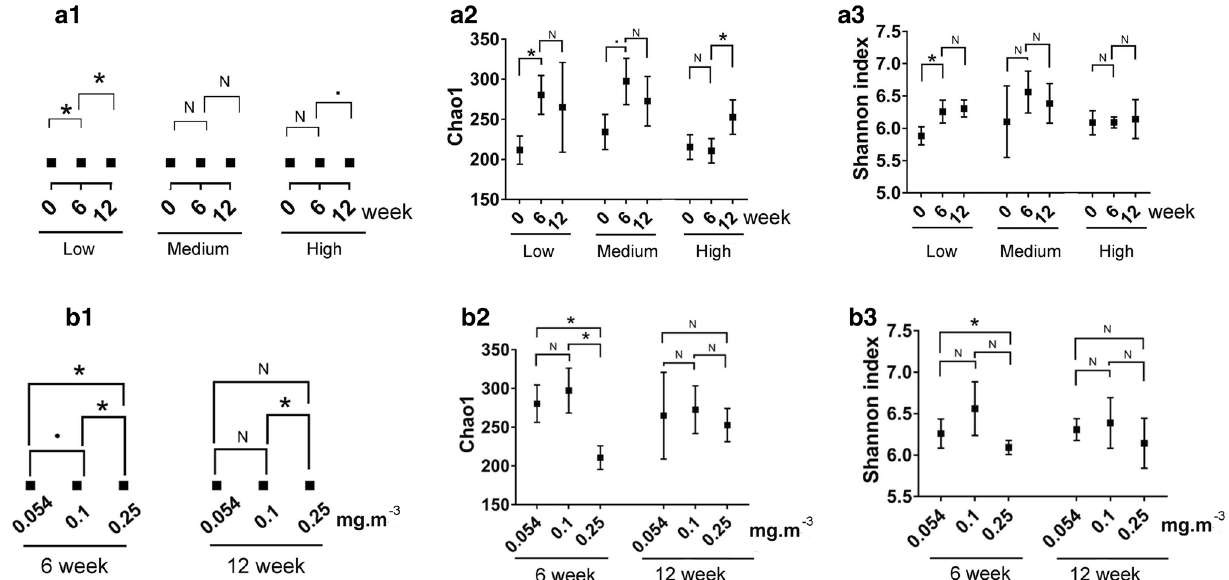
Figure 3. Variations of bacterial communities exposed to different CH 2 O levels. Permutational multivariate analysis of variance of the bacterial community according to exposure time based on Bray–Curtis distances ( a1 ), trends of Chao1 ( a2 ), and Shannon index ( a3 ); Permutational multivariate analysis of variance of the bacterial community according to CH 2 O levels at six and 12 weeks based on Bray–Curtis distances ( b1 ), comparation of Chao1 ( b2 ) and Shannon index ( b3 ) among different CH 2 O levels at six and 12 weeks. Mann–Whitney U test was performed. N no difference, · P < 0.1, * P < 0.05, ** P < 0.01. Mean ± std were shown in ( a2 ), ( a3 ), ( b2 ), ( b3